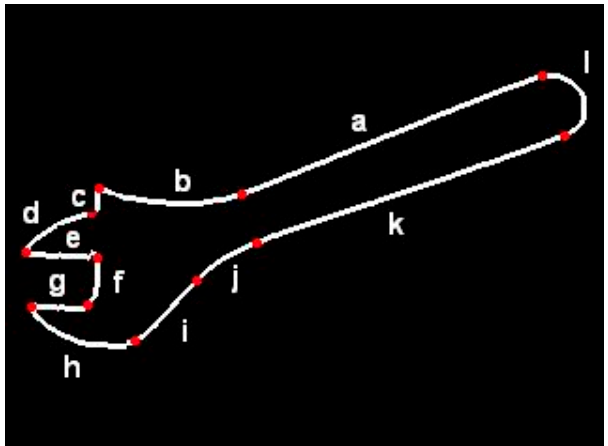
Figure 2. Visualization of flexible template “adjustable wrench”.